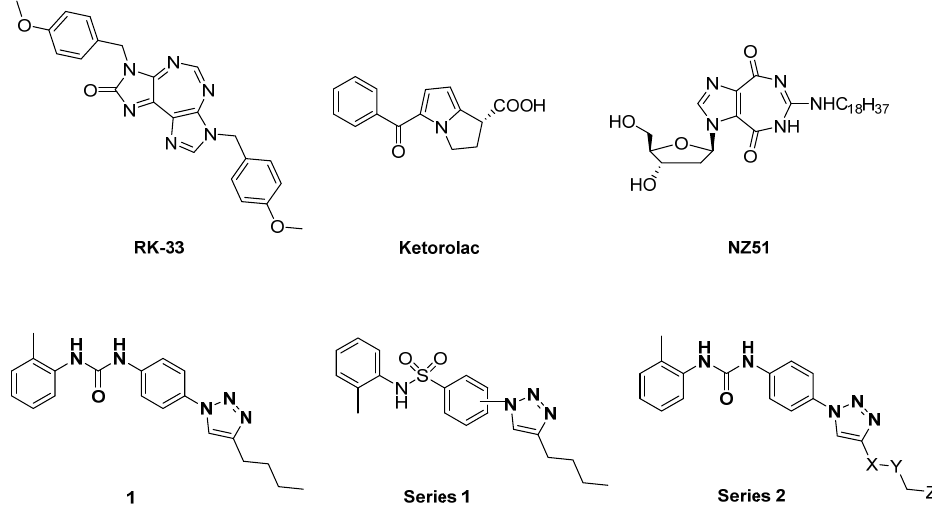
Figure 1. Two-dimensional (2D) structures of inhibitors of the DDX3X ATPase binging site published as anticancer compounds (upper line) and inhibitors of the DDX3X helicase binding site identified by replacing the urea of compound 1 with a sulfonamide (Series 1) and modifying the butyl side chain to increase the aqueous solubility (Series 2).